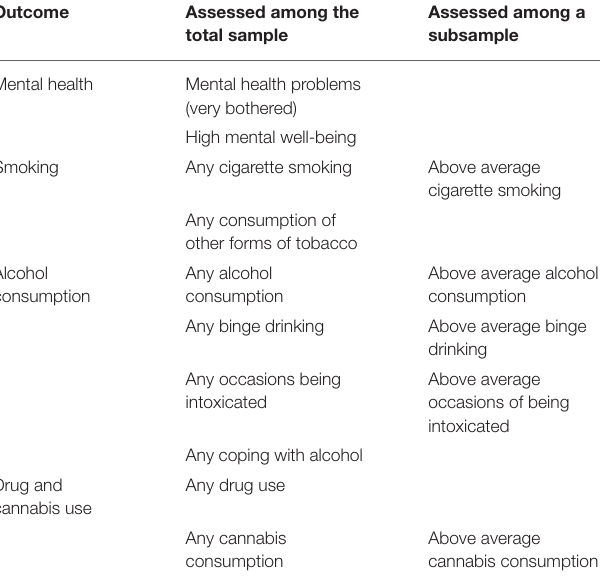
TABLE 1 | List of